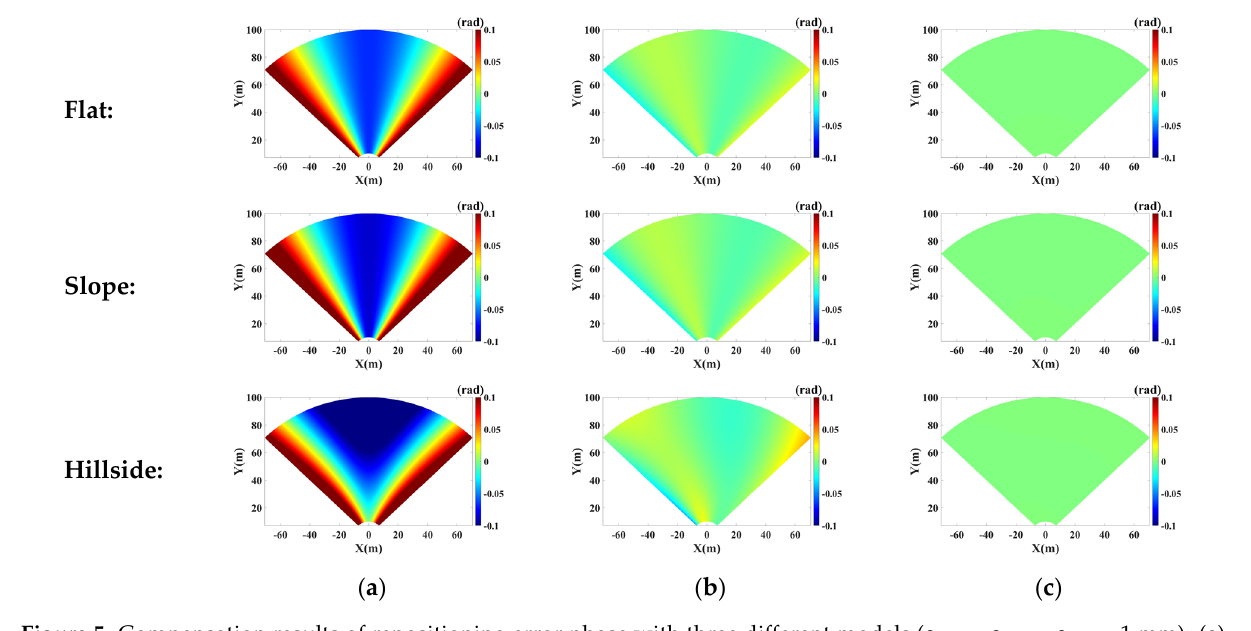
Figure 5. Compensation results of repositioning error phase with three different models ( ε x = ε y = ε z = 1 mm): ( a )